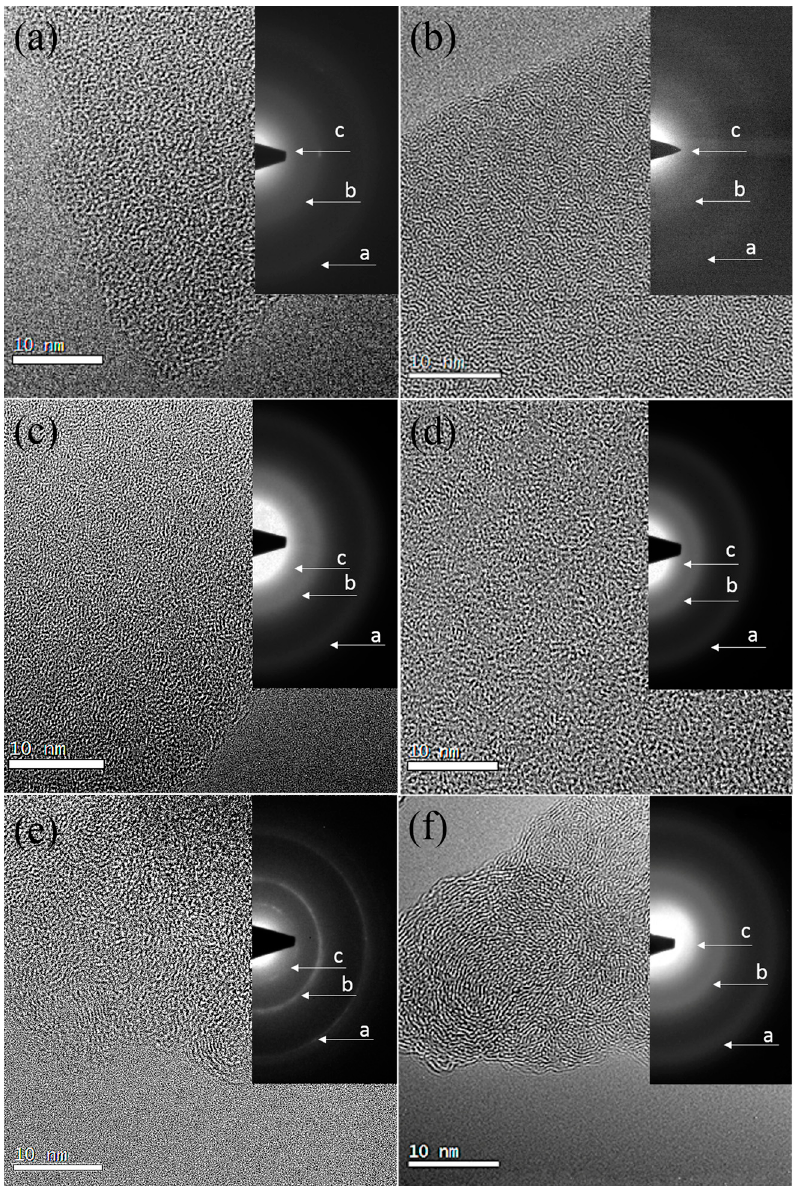
Figure 2. TEM images corresponding to the selected area electron diffraction pattern of FL-C:H films: ( a ) Is the image of the film, which is not subjected to the heat treatment, and the images of the annealed films at ( b – f ) of 200, 250, 300, 400, and 500 ° C , respectively.